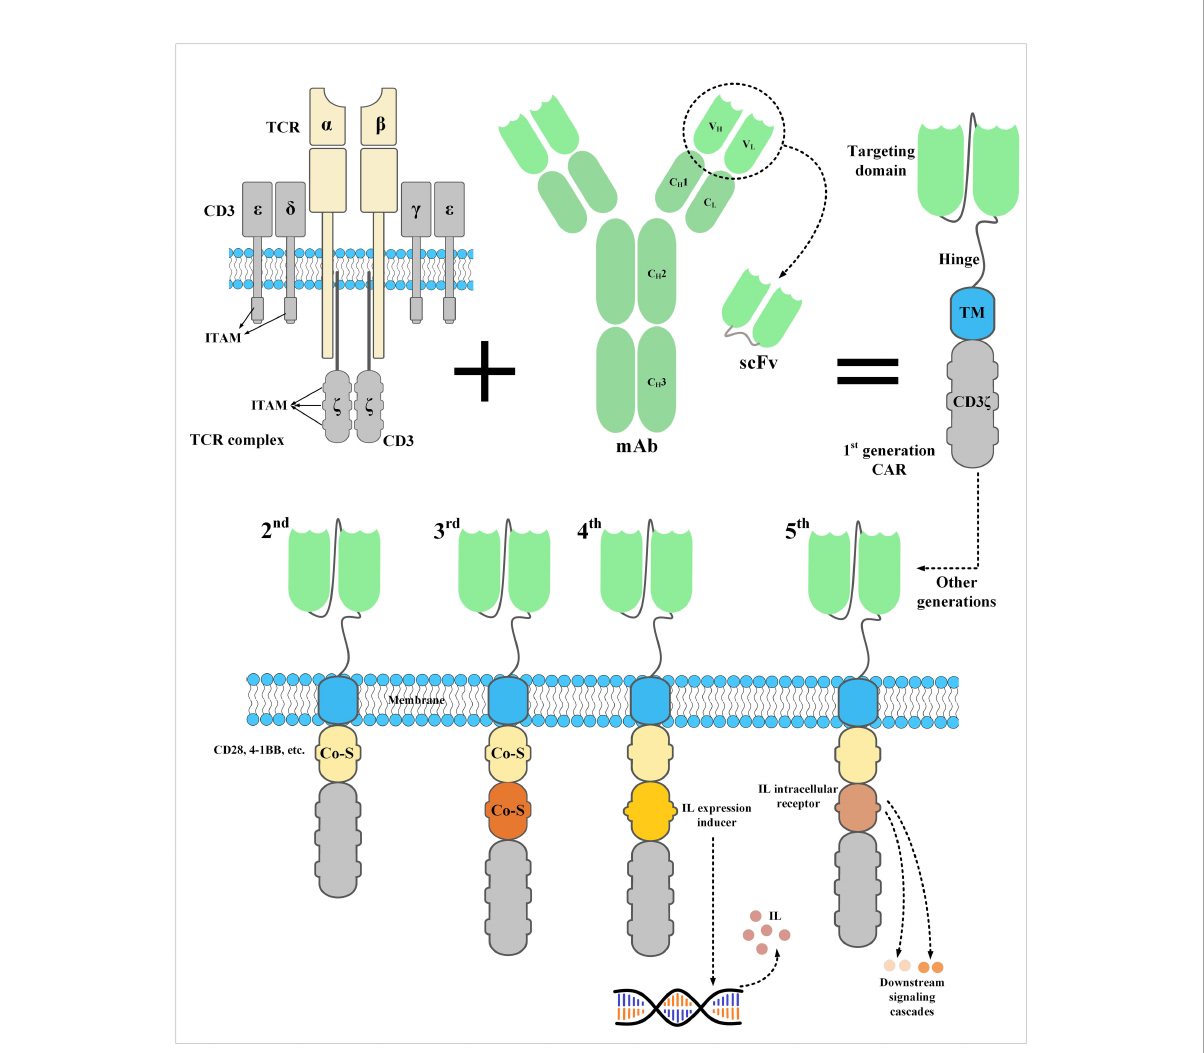
FIGURE 2 The structure of a CAR and its fi ve generations. CARs are the result of meticulous protein engineering. The targeting domain of CARs is usually derived from the single-chain fragment variable (scFv) of a monoclonal antibody. scFvs are made from the variable light chain (V L ) and variable heavy chain (V H ) of a monoclonal antibody fused together through a synthetic linker peptide. A spacer called hinge connects the targeting domain of CARs to their transmembrane domain, which connects the ectodomain to the endodomain. Currently, the endodomain of CARs consists of one or two costimulatory domains and an activation domain. An interleukin expression inducer domain and an interleukin intracellular receptor are also located on the endodomain of the fourth- and fi fth-generation CARs, respectively. Of note, the fi rst-generation CARs lacked a costimulatory domain which led to their inadequate in vivo persistence and weak antitumor responses. CAR, chimeric antigen receptor; Co-S, costimulatory domain; IL, interleukin; ITAM, immunoreceptor tyrosine-based activation motif; mAb, monoclonal antibody; scFv, single-chain fragment variable; TCR, T-cell receptor; TM, transmembrane